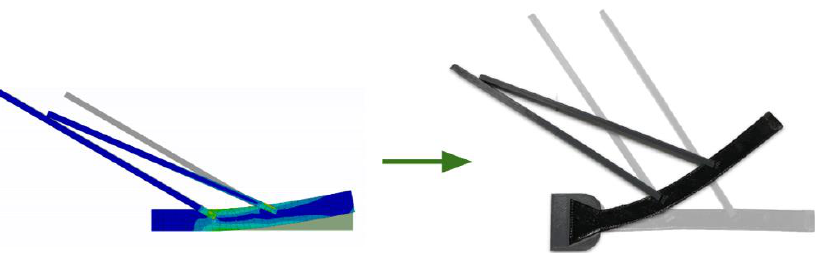
Figure 6. Comparing the scale interaction between the FEA model ( left ) and the 3D-printed fish scale ( right ).